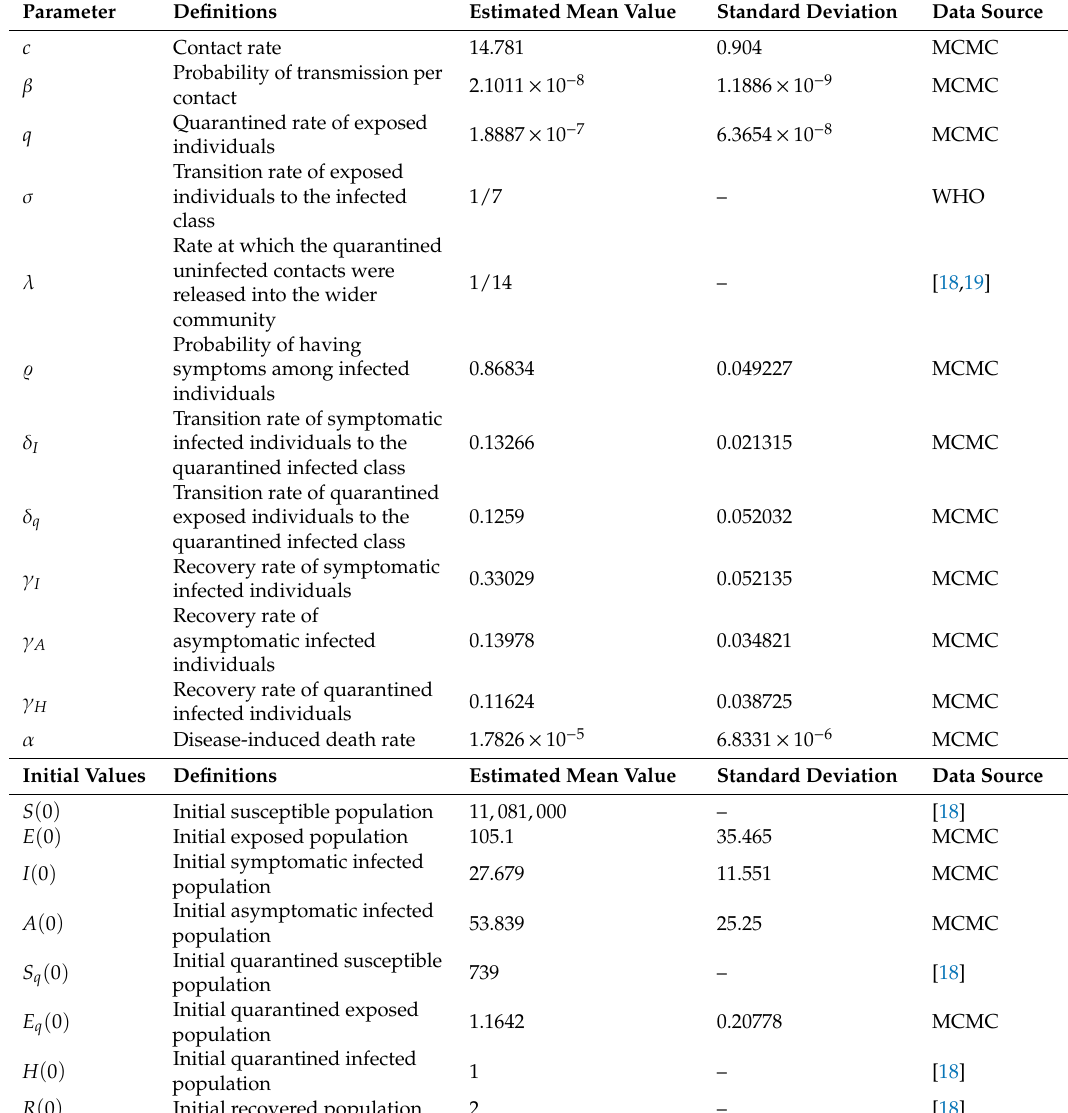
Table 1. Parameter estimates for 2019-nCoV in Wuhan,